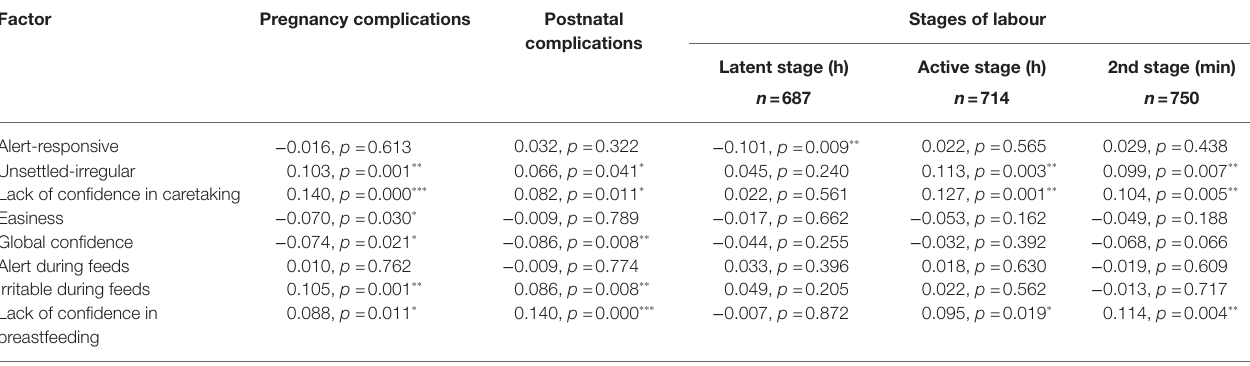
TABLE 3 | Pregnancy and postnatal complications, stages of labour and MABS. Factor Pregnancy complications Postnatal